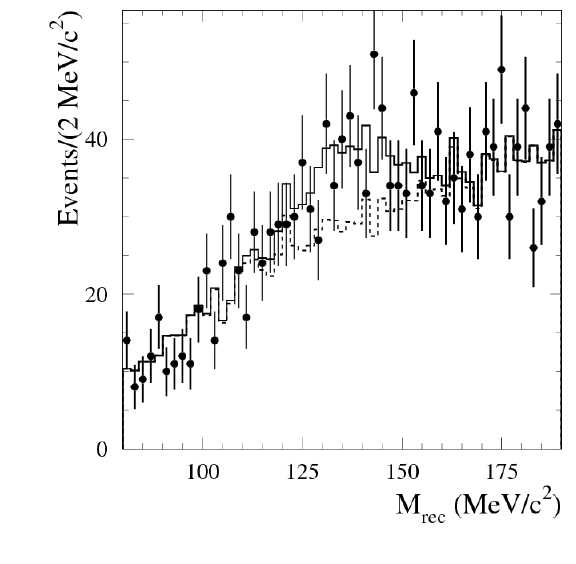
√ s = 1075 – 1375 MeV for data events (points with